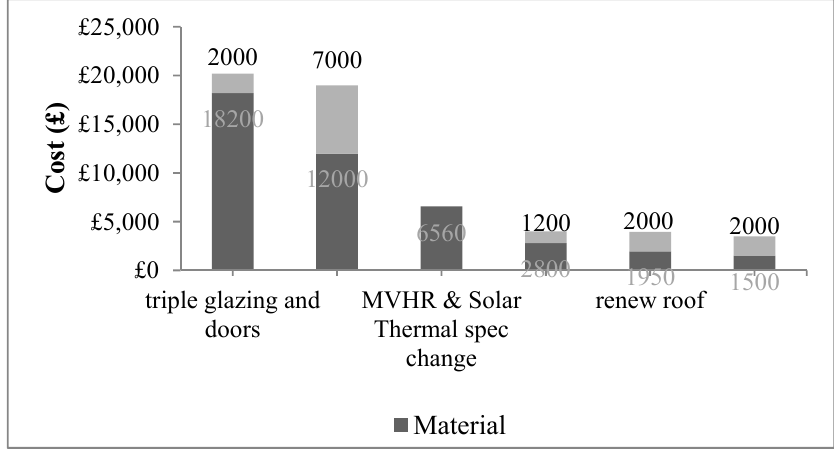
Figure 11. Cost of various low carbon technologies for the terraced